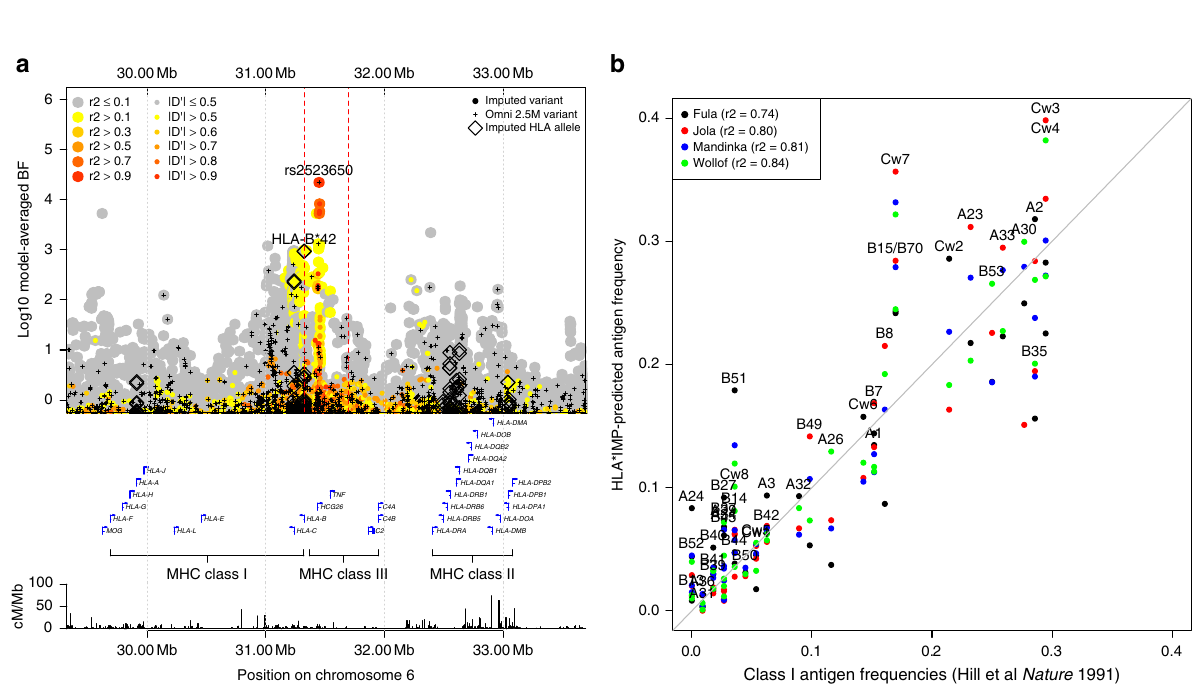
Fig. 6 Evidence for association across the HLA. a Evidence for association at genotyped SNPs (black plusses), imputed SNPs and INDELs (circles), and imputed classical HLA alleles (black diamonds) across the HLA region. Points are coloured by LD with rs2523650 as estimated in the African reference panel populations. Selected regional genes and the Hapmap-combined recombination map are shown below. b Comparison of HLA Class I antigen frequencies in distinct sample sets from The Gambia. X axis: antigen frequencies obtained by serotyping of 112 healthy adults 51 ; y axis: inferred antigen frequencies based on imputation of 2-digit alleles in the four major ethnic groups (colours) in our Gambian dataset. B*15 alleles encode a number of antigens 100 including B70 and we combine results for B15 and B70